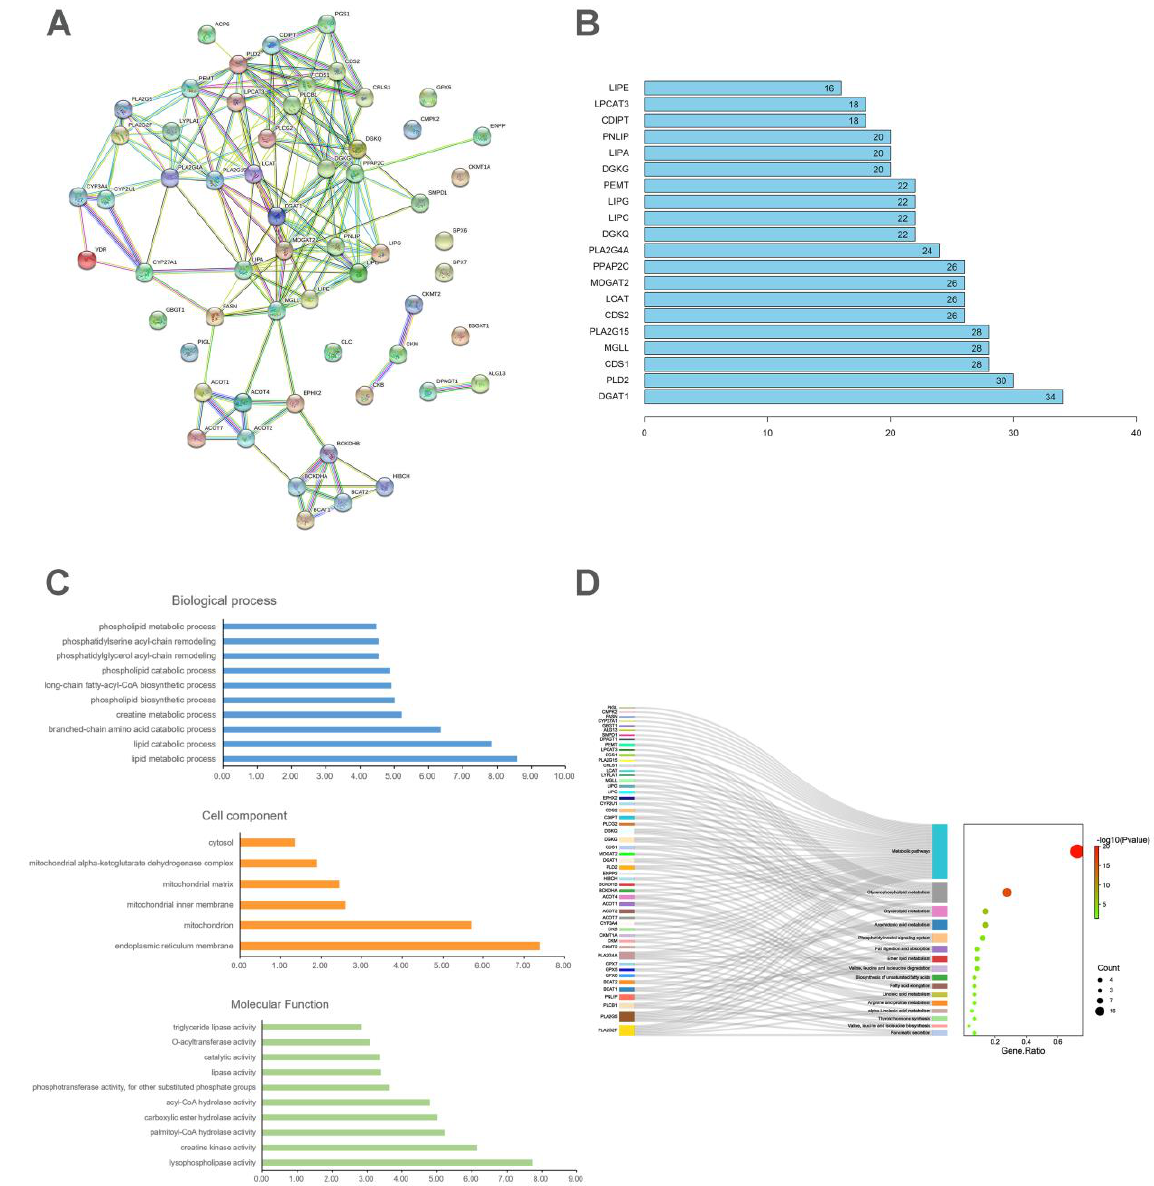
Figure 5. Protein – protein interactions and enrichment pathway analysis of regulatory enzymes. ( A ) Regulatory protein network map. ( B ) Top 20 proteins with high degree value in the PPI network. ( C ) GO enrichment analysis of the regulatory proteins. ( D ) KEGG enrichment analysis of the regulatory